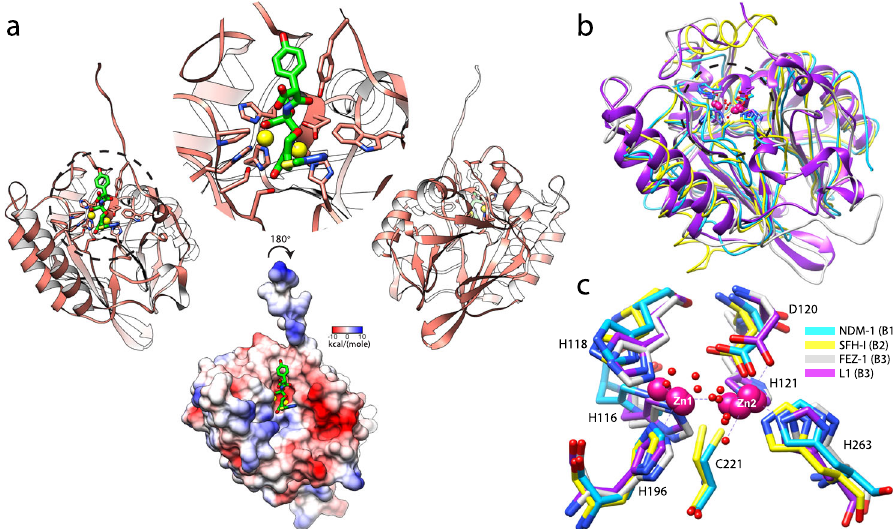
Fig.2|OverviewofcrystalstructureofL1from S.maltophilia inacomplexwith hydrolyzed moxalactam. a Structure of L1 is shown as cartoon (salmon), active site contains moxalactam (green sticks), and two zinc ions are showed in yellow. Bottom surface depicts the Coulombic electrostatic potential plotted on the sur- face of the L1 in complex with moxalactam at 295K (electrostatic potential calcu- latedusing defaultsettings in UCSFChimera). b Cartoon representation ofL1MBL superposedwithcrystalstructuresofB1,B2,andB3subclassesofMBLsdepictedas licorice models. Crystal structure of L1 MBL determined at room temp using SSX